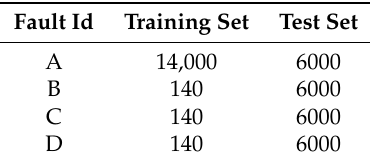
Table 2. Number of observations in the training and test sets used for hold out validation. The training set is clearly